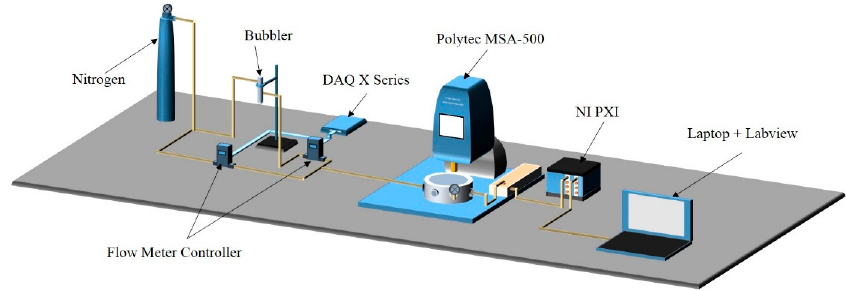
Figure 3. A schematic of the optical gas sensing setup.